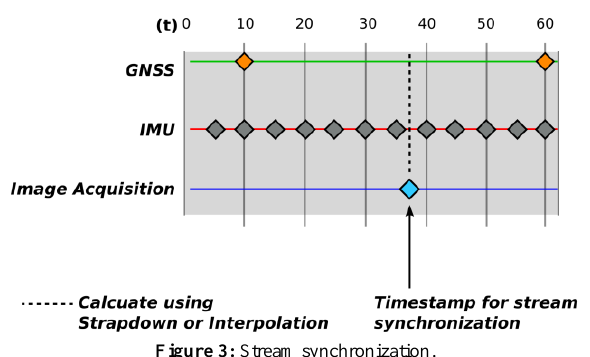
Figure 3: Stream